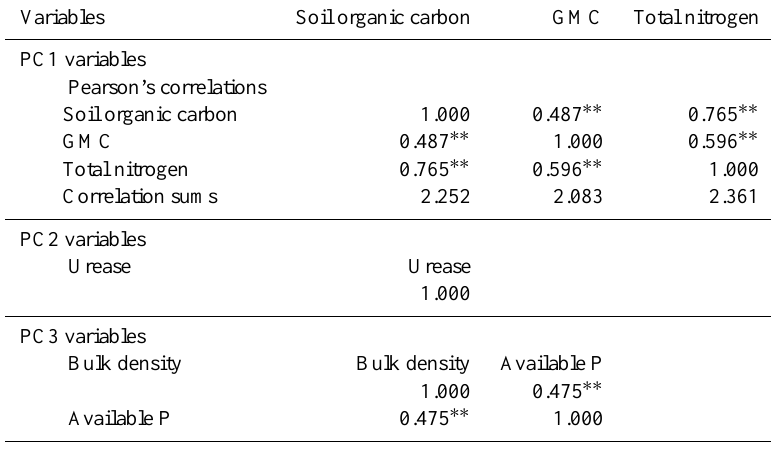
Table 3. Correlation matrix for highly weighted variables under PCs with high factor loading.